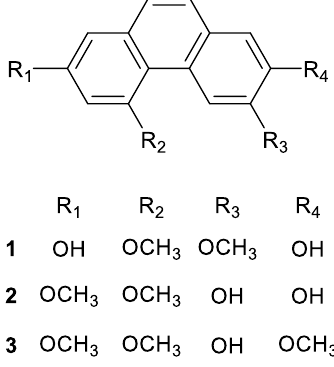
Figure 1. Structures of Phenanthrenes 1 – 3.